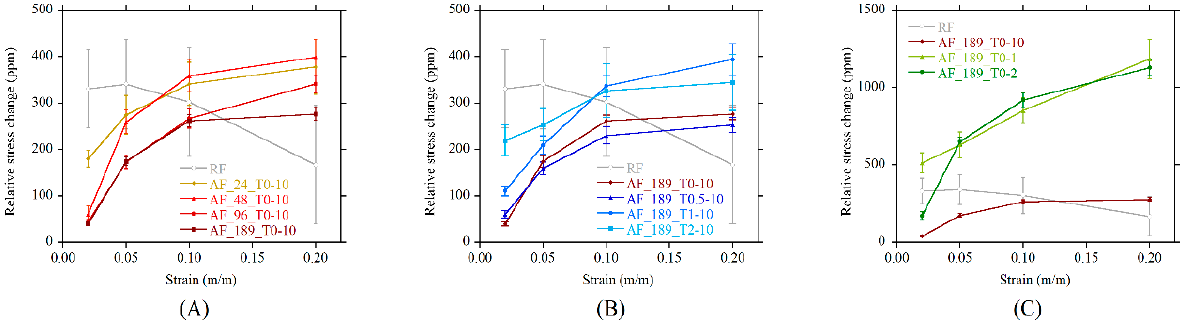
Figure 12. Relative stress change (RSC) under magnetic field versus prestrain as function of ( A ) magnetic field strength, ( B ) switch-on time, ( C ) switch-off time.